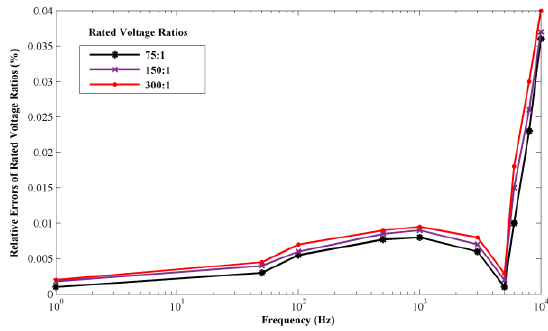
Figure 4. Relative errors of rated voltage ratios (75:1, 150:1, and 300:1).